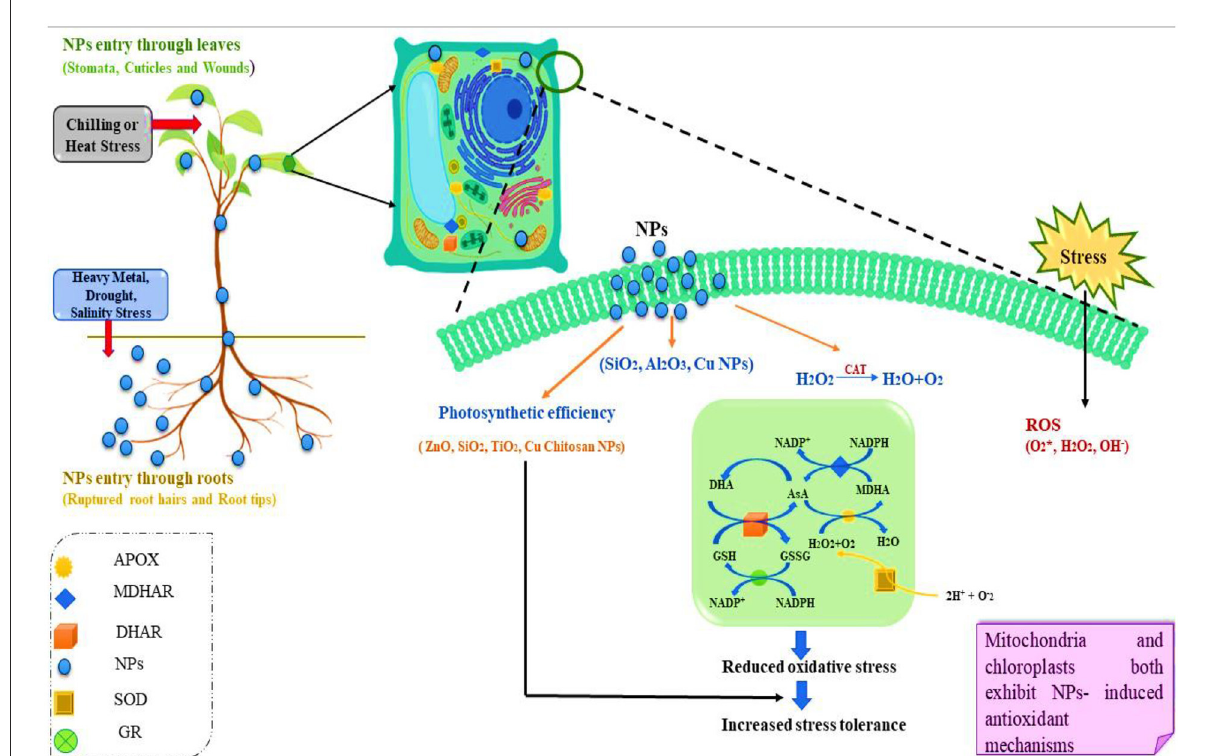
FIGURE2 Pictorial illustration of the mechanism involved in remediating HM contaminated soil. The presence of NPs enhances the adsorption of HM by rising the soil pH reducing the bioavailability and mobility of HM in soil. Nanoparticles can help in stimulating the defense cascade in plants by synthesizing the ROS which promote the ability of the plant for increased nutritional uptake and improving plant growth (APOX, ascorbate peroxidase; MDHAR, monodehydroascorbate reductase; DHAR, dehydro-ascorbate reductase; NPs, nanoparticles; SOD, superoxide dismutase; GR, glutathione reductase; ROS, reactive oxygen